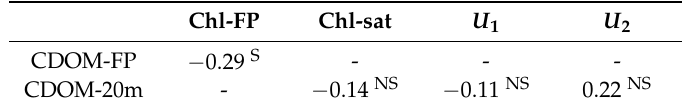
Table 2. The correlation coefficients of the relationship between Colored Dissolved Organic Matter (CDOM), measured from FluoroProbe profiles (CDOM-FP, 0–60 m depth) and integrated in the upper 20 m layer (CDOM-20m), and the in-situ measured FluoroProbe Chl-a (Chl-FP), the satellite MODIS-A chlorophyll-a (Chl-sat), and the first two spatial modes obtained from the singular value decomposition (SVD) of a R matrix composed by MODIS-A nLw data in the region off central Chile (35–38 ◦ S, 72–76 ◦ W).